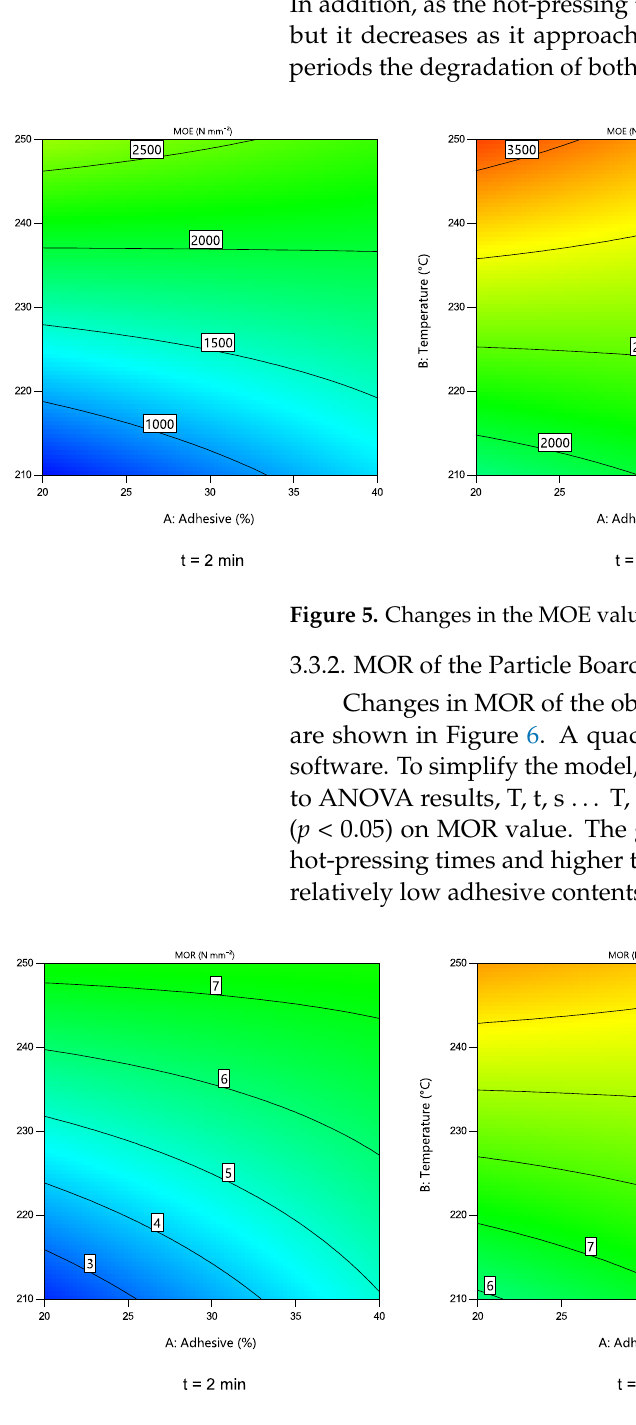
Figure 6. Changes in the MOR value of the boards depending on the hot-pressing